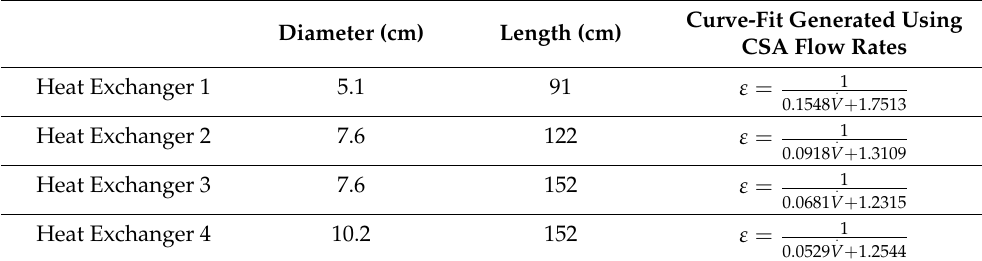
Table 4. Characteristics of the DWHR heat exchangers used in